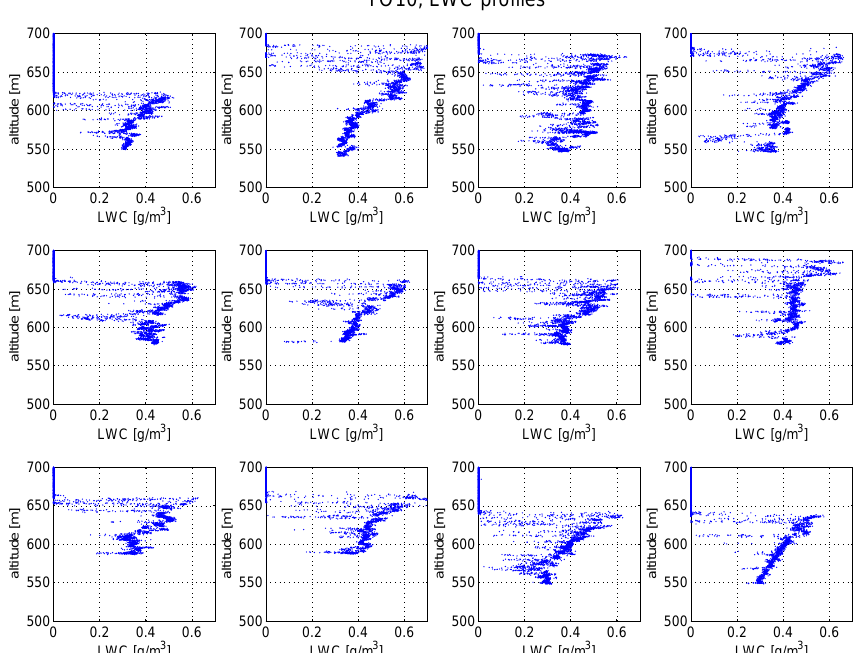
Fig. 8. Typical profiles of LWC collected on porpoises in flight TO10. Each point corresponds to a 1.4 m average (40 Hz data). Four consecutive profiles are shown in each row. Successive rows are from different flight legs in order to illustrate variability of LWC for the whole flight.